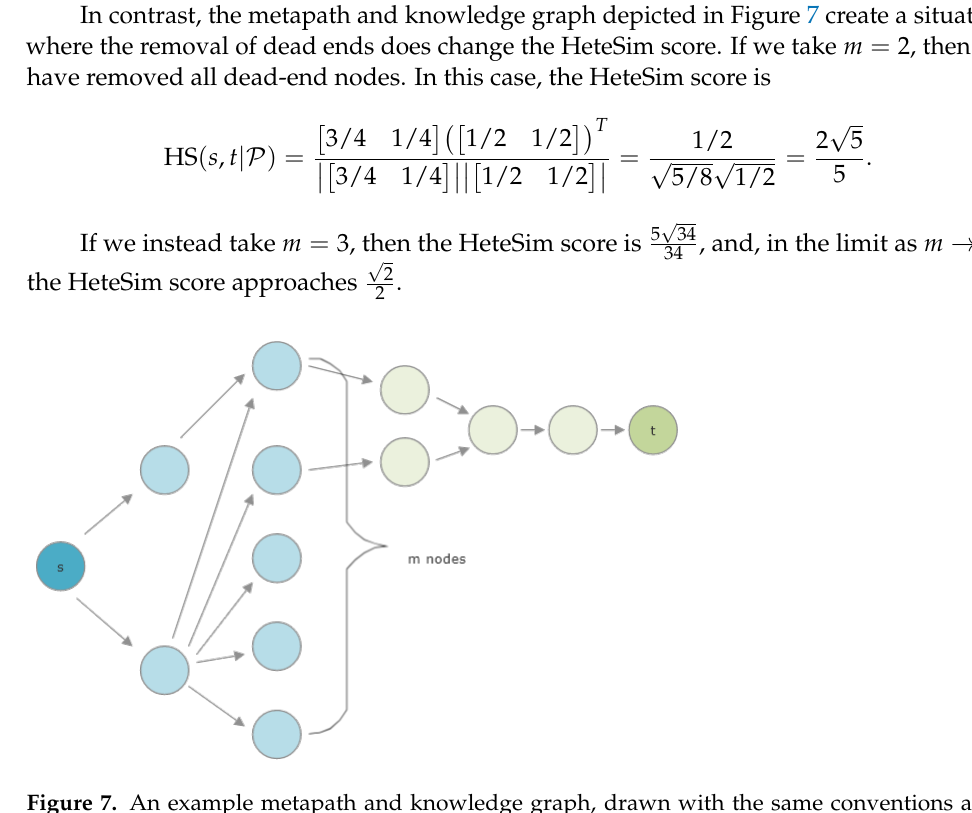
Figure 6. An example knowledge graph. Here, we use the convention that nodes are organized by type into vertical columns in the order that they appear in the metapath. We also only show edges that may appear in some metapath instance. This example has m 1 − 1 dead-end nodes on the left and m 2 − 1 dead-end nodes on the right. The HeteSim score of s and t with respect to the metapath is 1 for all values of m 1 and m 2 .